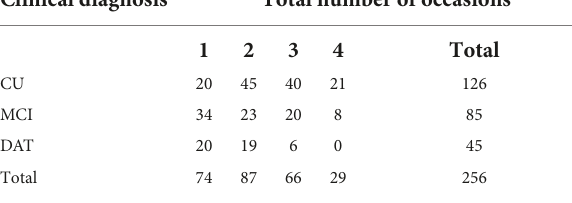
TABLE 2 Participant counts for total number of measurement occasions by clinical